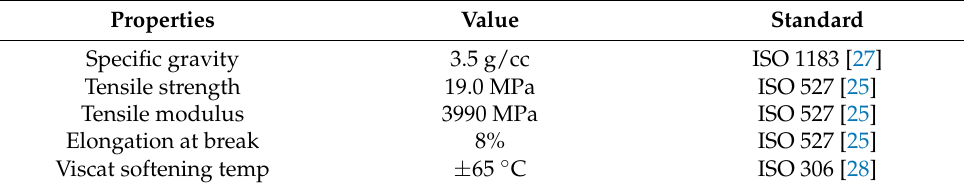
Table 1. Selected properties of the Formfutura MetalFil Ancient Bronze filament.